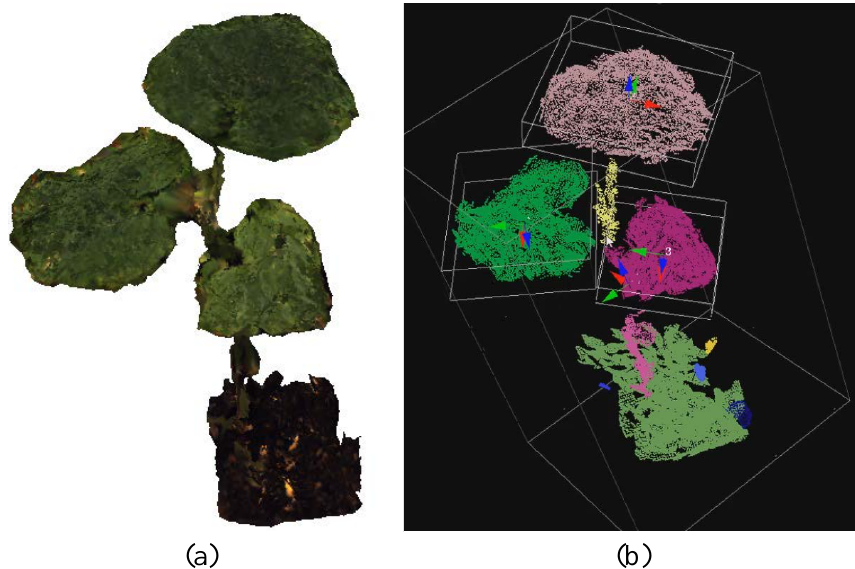
Figure 8. 3D model of a cucumber plant ( a ) and its leaf detection result ( b ), where each part of the plant is color-coded and the bounding boxes of leaves are